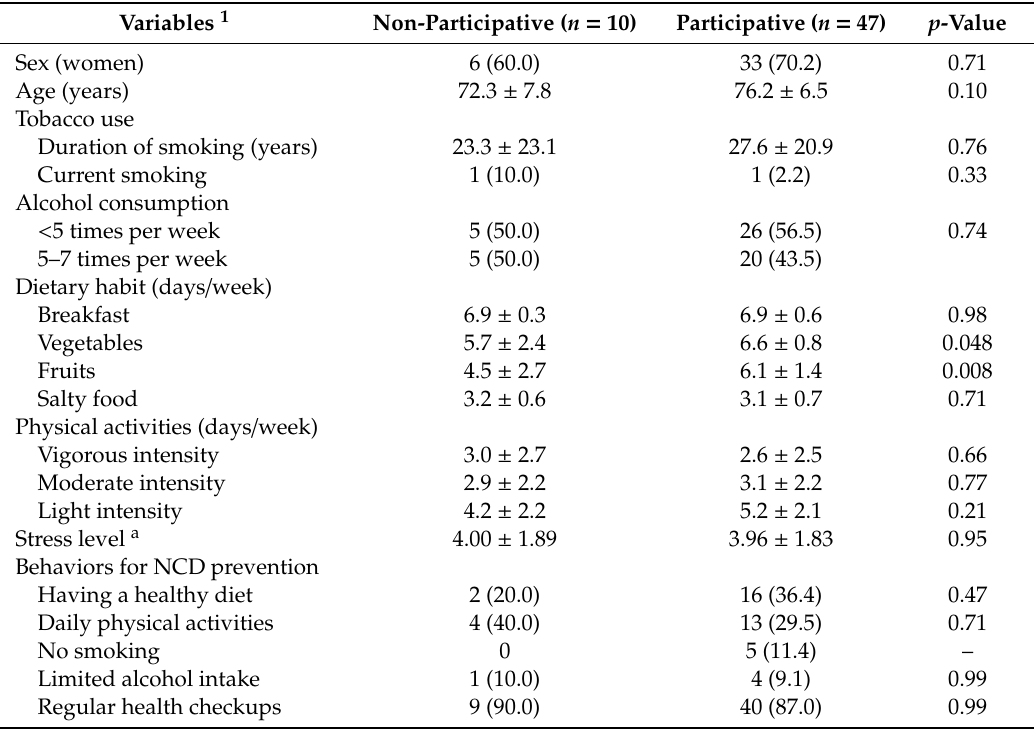
Table 4. Lifestyle and behaviors for NCD prevention of socially participative and non-participative groups in Japanese older